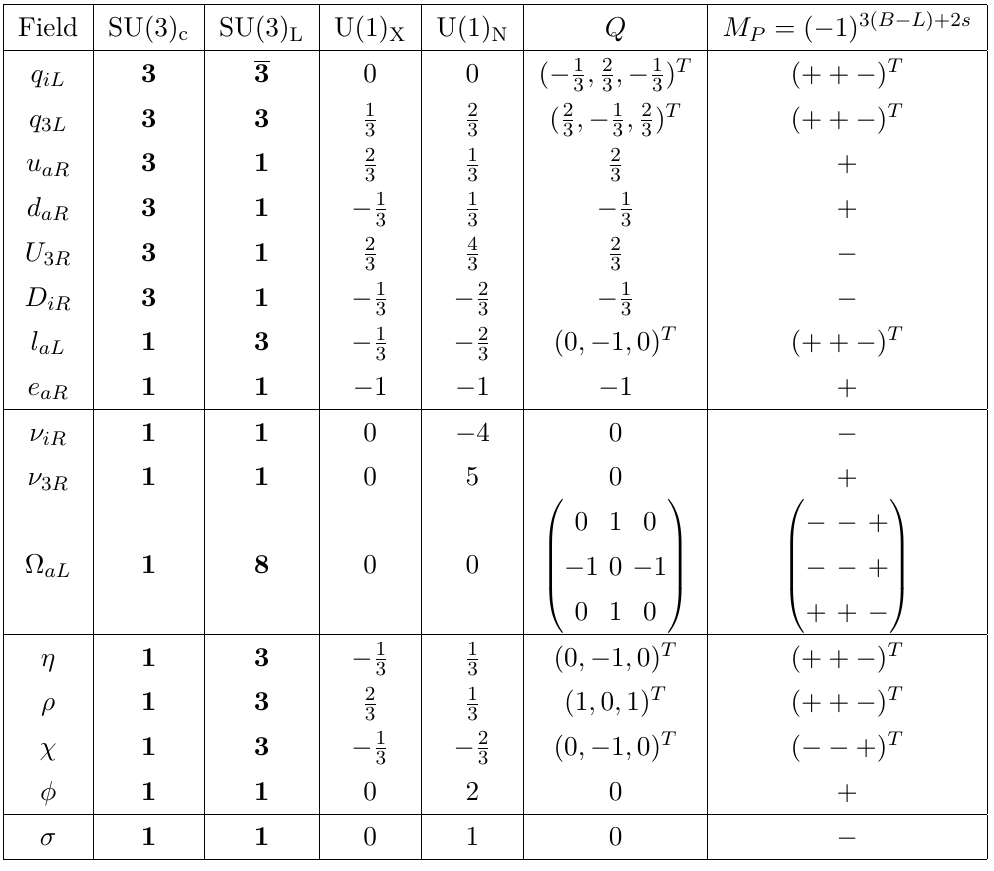
Table 1 . 3311 model field content ( a = 1 , 2 , 3 and i = 1 , 2 are family indices). Note the non- standard charges of the ν R